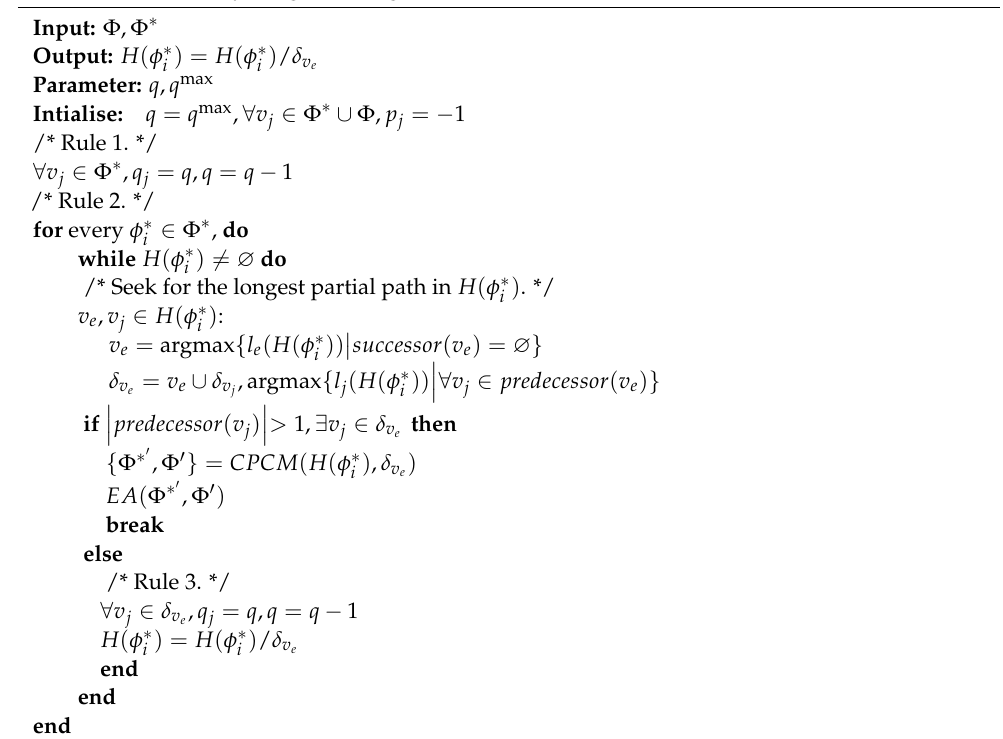
Algorithm 2: Priority assignment algorithm EA ( Φ ∗ , Φ